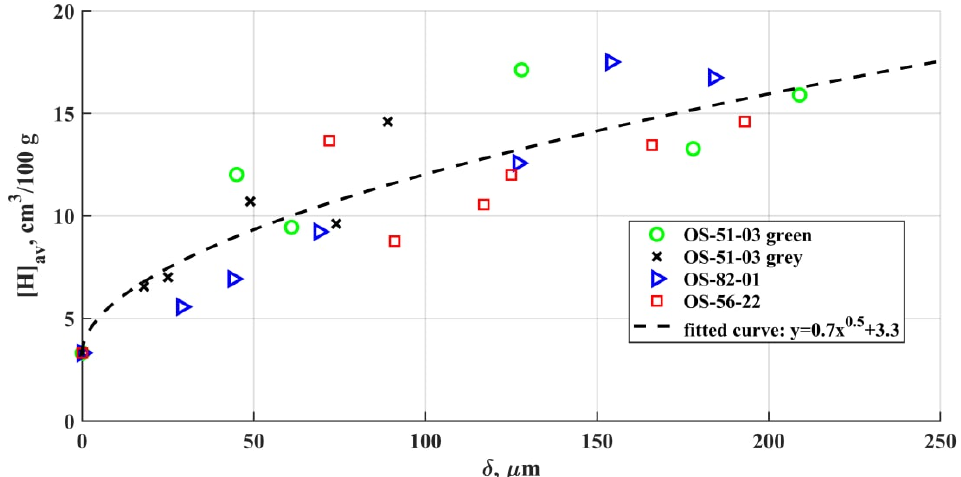
Figure 7. Relation between the diffusible hydrogen amount in the metal and OSCs thickness on the surface. the